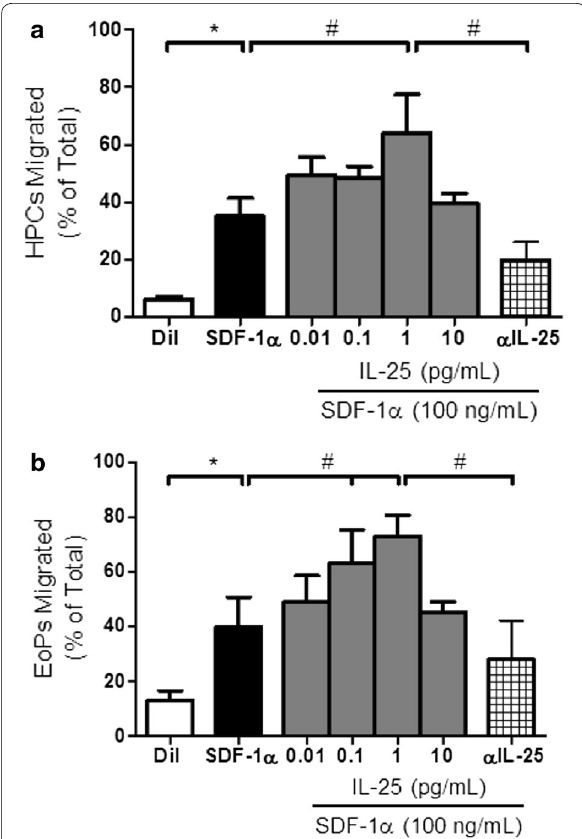
Fig. 2 IL-25 priming of ( a ) HPC and b EoP migration, in vitro. Pre- incubation overnight with IL-25 primed the migrational responsive- ness of both HPC and EoP stimulated by SDF-1α. SDF-1α alone induced migration. Data are presented as mean (*p < 0.05 comparison to diluent; # p < 0.05 comparison to SDF-1α alone)